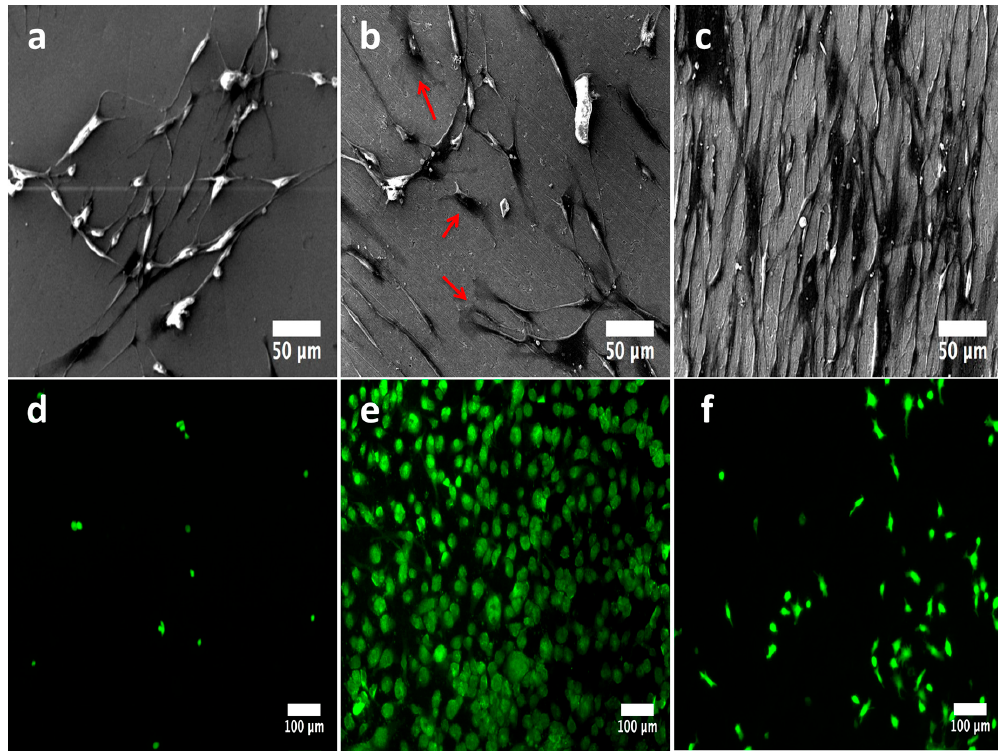
Figure 11. Osteoblast behavior cultured on the investigational materials after 24 h: ( a ) adhered osteoblasts on the flat surface; ( b ) 80 nm NTs illustrating promoted adhesion with long and interconnecting filopodia projections (red arrows highlight the formation of anchored sites); ( c ) cultured osteoblasts on the rough disk; ( d ) representative viable cells detected on the flat material; ( e ) vital osteoblasts analyzed on the NTs; ( f ) anchored vital osteoblasts on the rough Ti6Al4V.